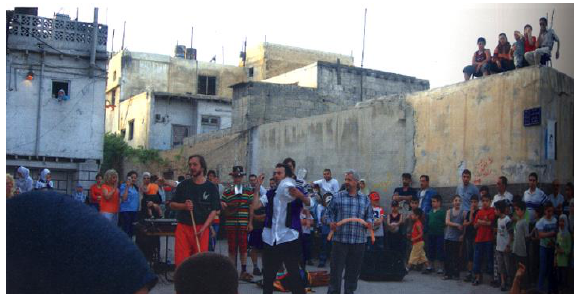
Figure 10. Café-Gallery, R.Aboukhater, May 2010.